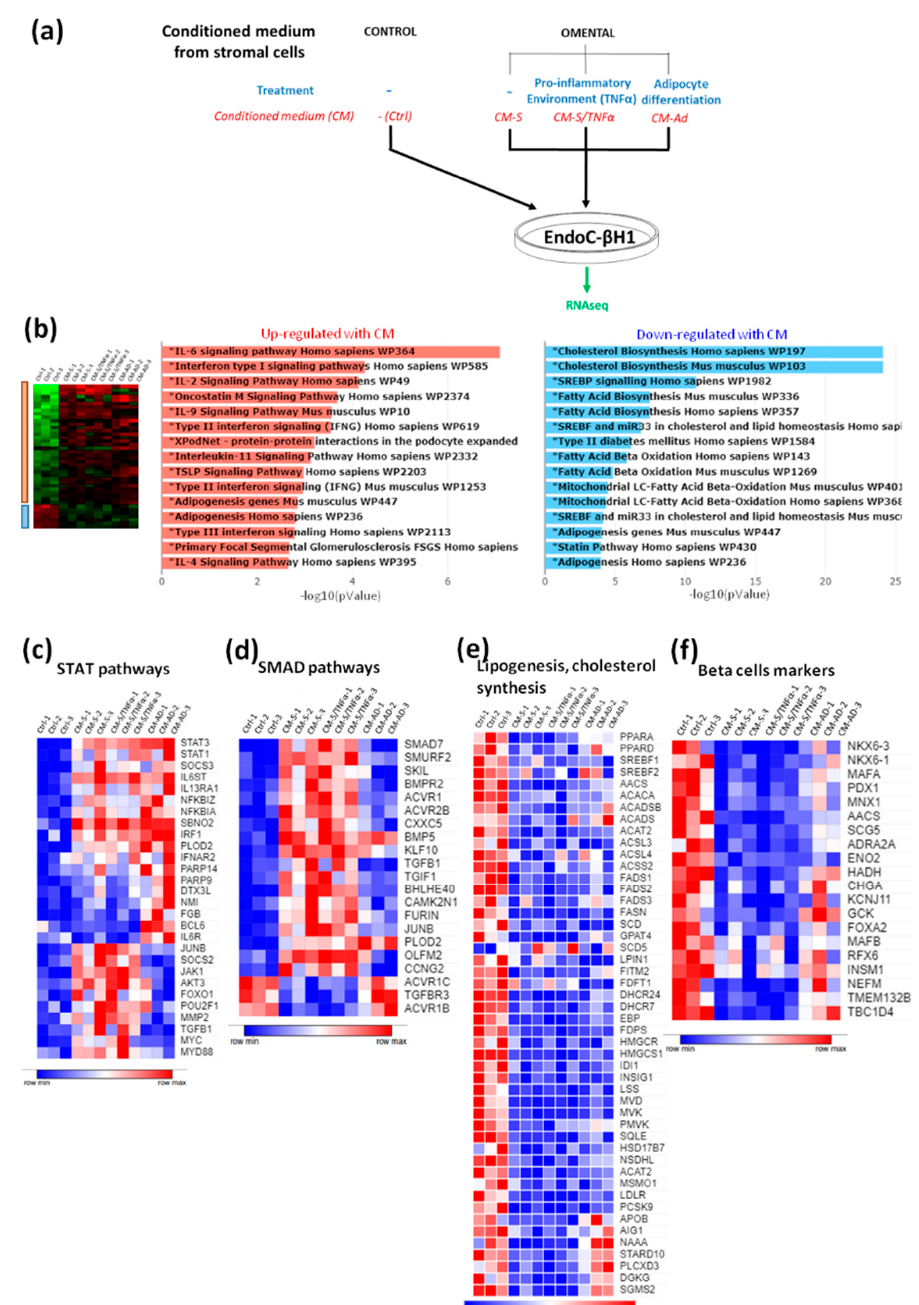
Figure 1. Impact of conditioned media (CM) from omental adipose stromal cells on EndoC- β H1 cells. ( a ) Experimental scheme: CM was prepared from stromal cells isolated from omental adipose tissue and cultured without (CM-S) or with TNF- α (CM-S/TNF- α ), or differentiated into adipocytes (CM- AD). CMs were added to EndoC- β H1 cells and RNAs were prepared 48 h later for transcriptomic analyses. ( b ) Identification using Wikipathway of up- and down-regulated pathways in EndoC- β H1 cultured in omental conditioned media. ( c – f ) Heatmaps of genes of the STAT pathway ( c ), of the SMAD pathway ( d ), of lipogenesis and cholesterol synthesis ( e ) and enriched beta